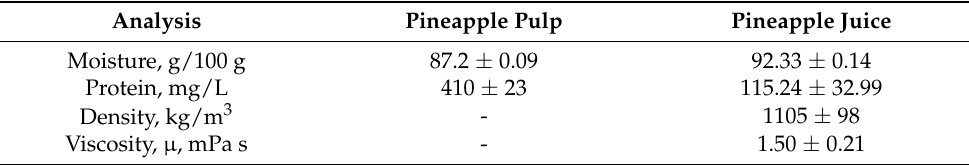
Table 1. Properties of the pineapple pulp and juice at 25 ◦